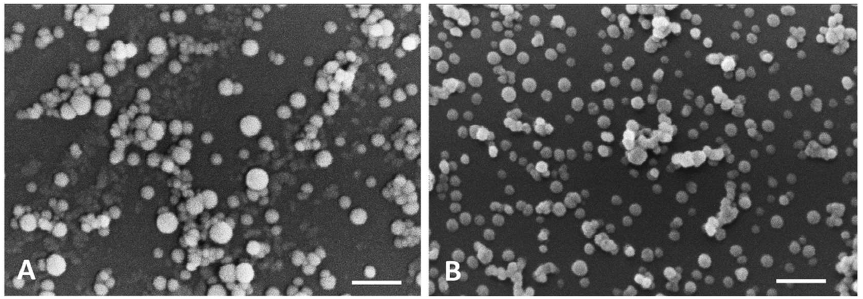
Figure 7. Scanning Electron Microscopy (SEM) micrographs of: ( A ) Albumin empty nanoparticles (scale bar: 1 μm) and ( B ) Parvifloron D-loaded nanoparticles (scale bar: 1 μm).